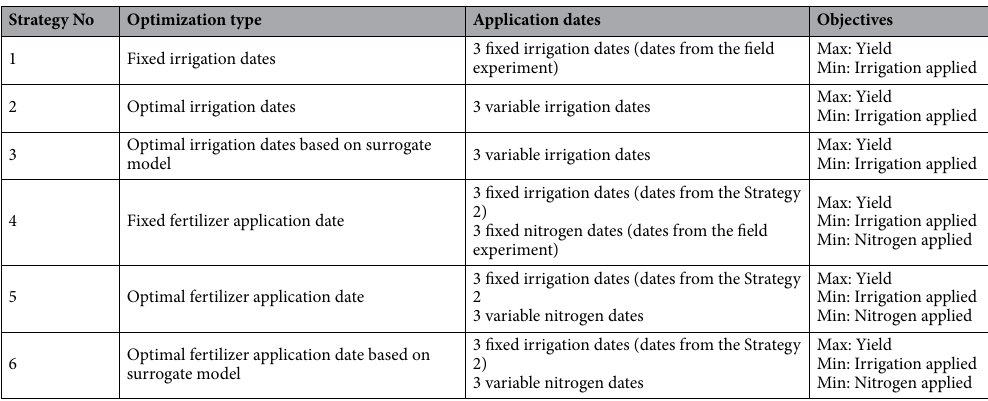
Table 1. Details of the 6 strategies of the experimental